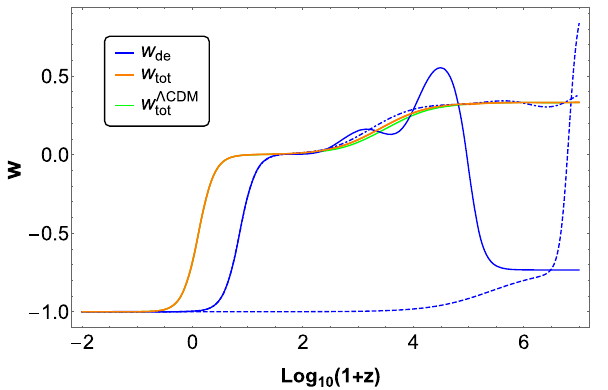
Fig. 6 We depict the evolution of the energy density of dark energy ρ ρ de (blue), dark matter (including baryons) m (orange) and radiation ρ = − 0 . 8, σ = 17 and r (green) as functions of the redshift z , for s λ = 0 . 01. The dashed line corresponds to the initial conditions x = i 1 × 10 − 11 , y i = 7 . 3 × 10 − 13 , u i = 1 × 10 − 8 , (cid:2) i = 0 . 999875, solid blue line to x i = 1 × 10 − 8 , y i = 7 . 3 × 10 − 13 , u i = 1 × 10 − 23 , = 0 . 999875, and dot-dashed blue line to x = 0 . 0768467, y = (cid:2) i i i 7 . 3 × 10 − 13 , u i = 0 . 002, (cid:2) i = 0 . 995916. It is observed the two new scaling regimes during the radiation and dark matter era. To obtain this plot we have found the current values for the fractional energy densities ( 0 ) = 0 . 68 and dark matter Ω ( 0 ) = 0 . 32, at redshift of dark energy Ω m de z = 0,accordingtoPlanckresults[7].Also,duringthescalingradiation ( r ) < 0 . 045[127],andthe epochwehaveimposedtheBBNconstraint Ω Fig. 8 We plot the physical evolution curves in the phase space for the de constraint for the field energy density during the scaling matter epoch values of parameter s = − 0 . 8, σ = 17 and λ = 0 . 01, and for the three Ω ( m ) < 0 . 02 (95% CL), at redshift z ≈ 50, from CMB measurements different set of initial conditions x i = 1 × 10 − 11 , y i = 7 . 3 × 10 − 13 , de u i = 1 × 10 − 8 , (cid:2) i = 0 . 999875 (brown), x i = 1 × 10 − 8 , y i = 7 . 3 × 10 − 13 , u i = 1 × 10 − 23 , (cid:2) i = 0 . 999875 (black), and x i = 0 . 0768467,